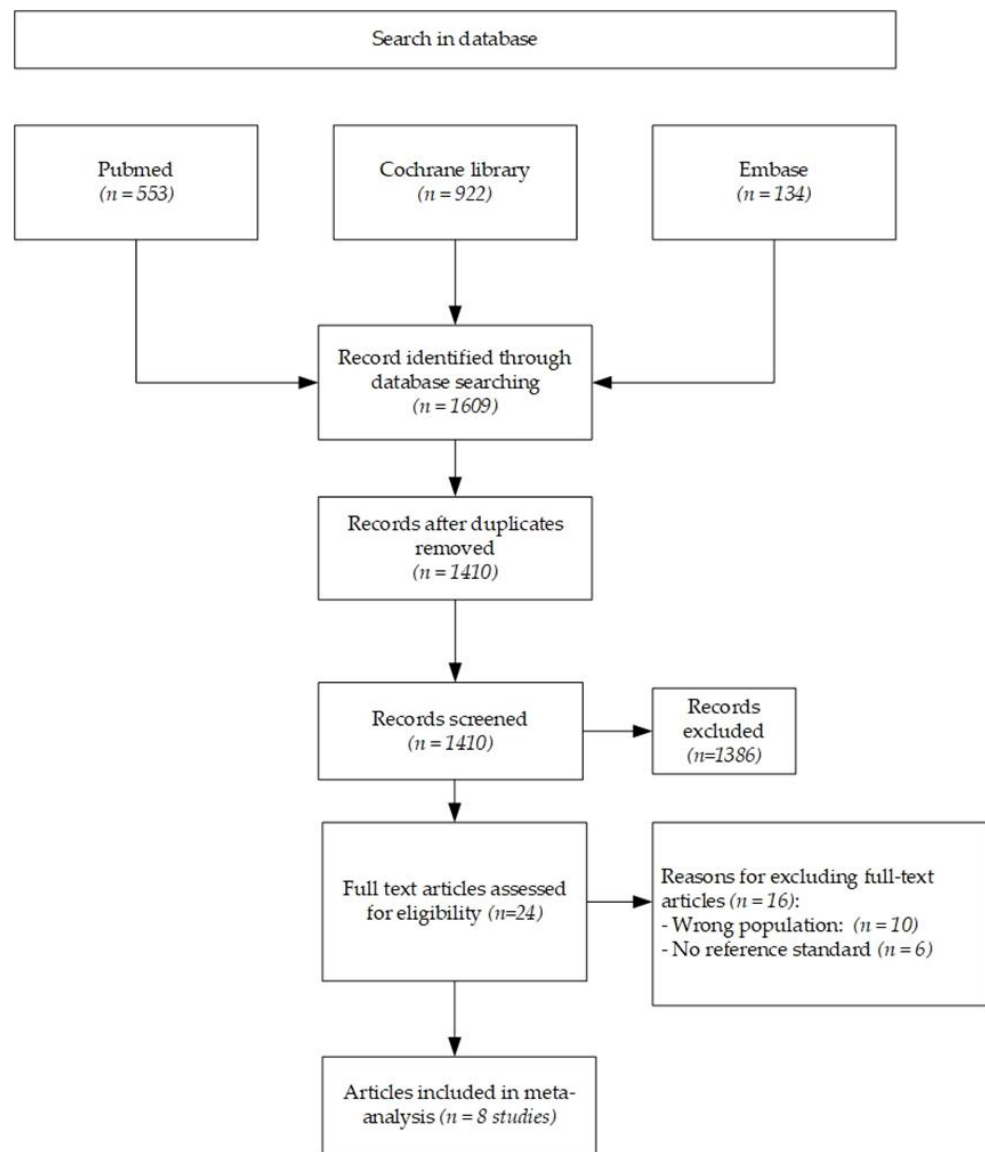
Figure 1. Flow diagram of included